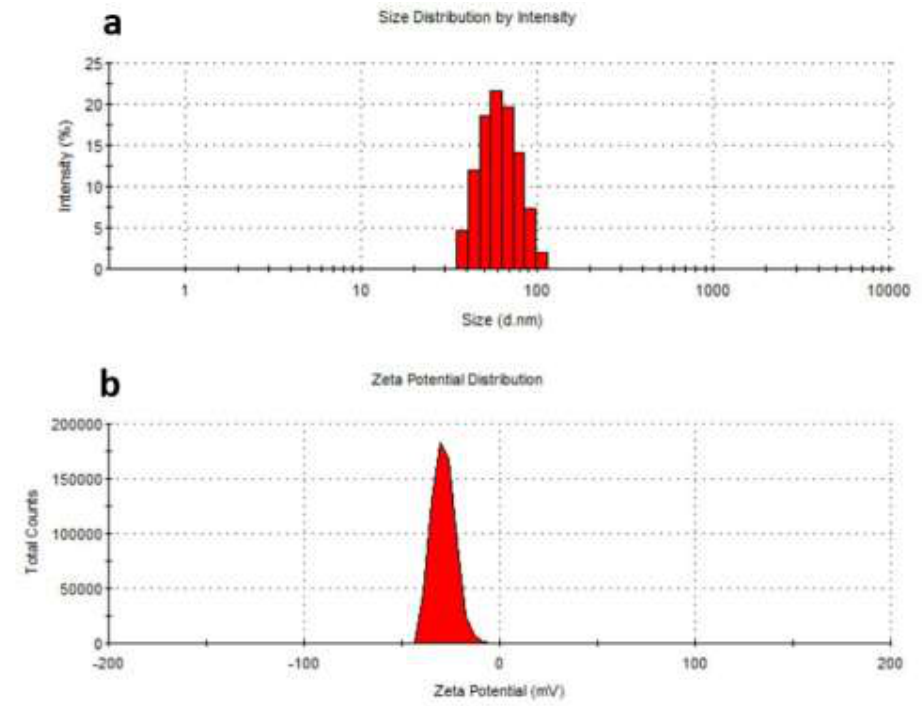
Figure 3: Size distribution and zeta potential of Al